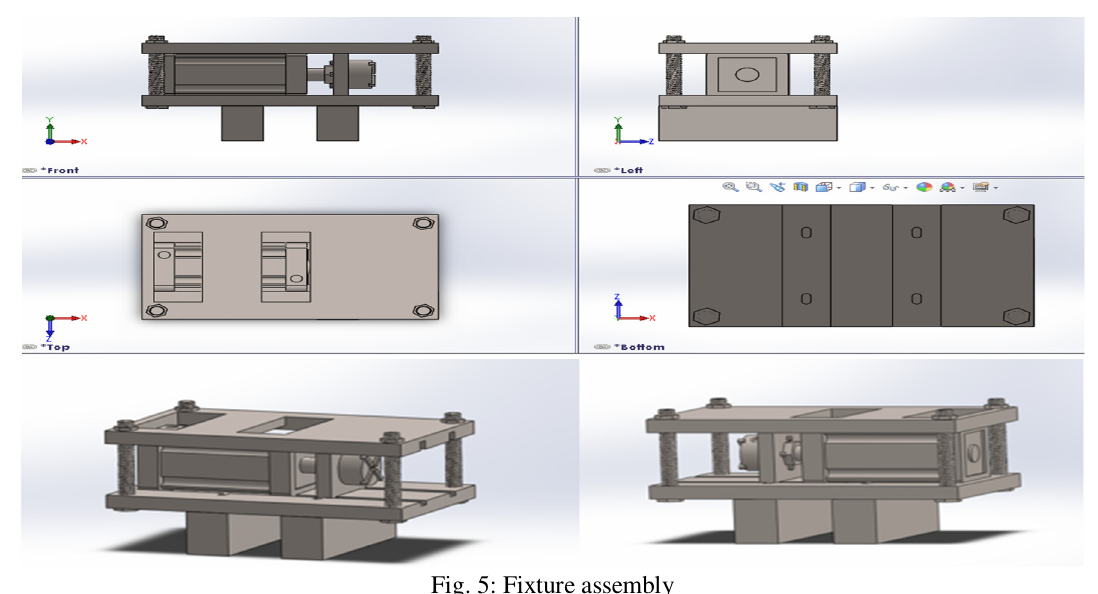
Fig. 5: Fixture assembly